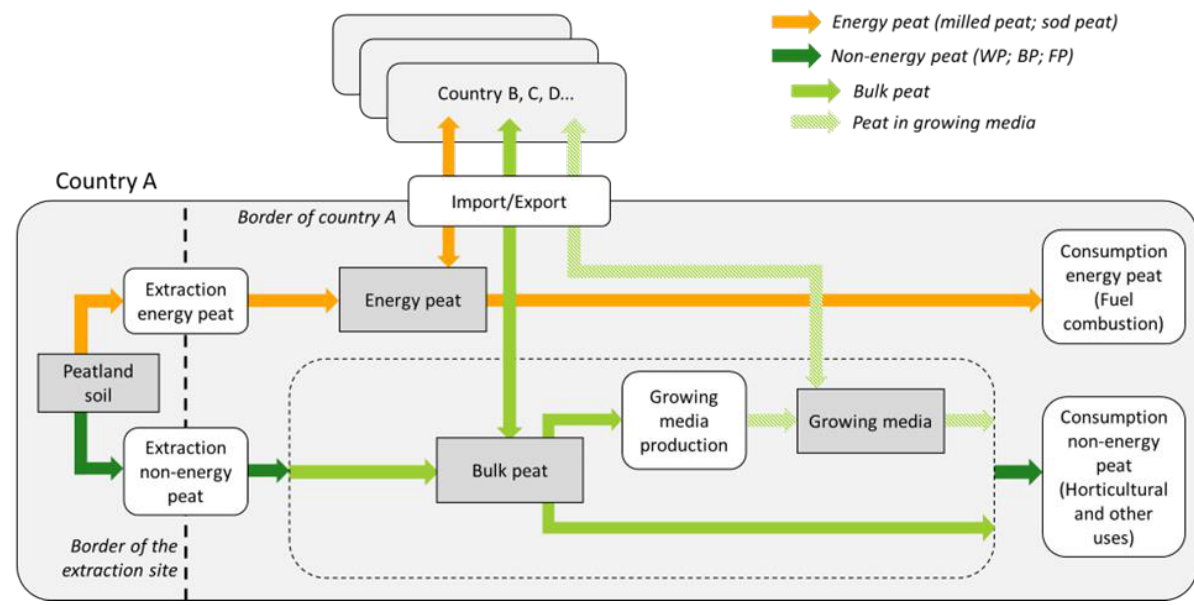
Figure 1. Schematic representation of the system considered. WP = White bog peat; BP = Black bog peat; FP = fen